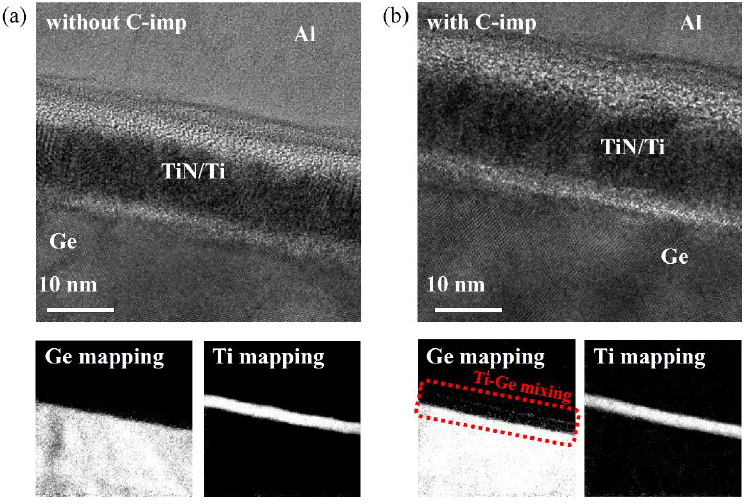
Figure 6. Cross-sectional TEM images and corresponding electron energy loss spectroscopy (EELS) mapping images for Ge and Ti in the Ti/Ge contacts ( a ) without and ( b ) with C-imp after RTA at 600 ◦